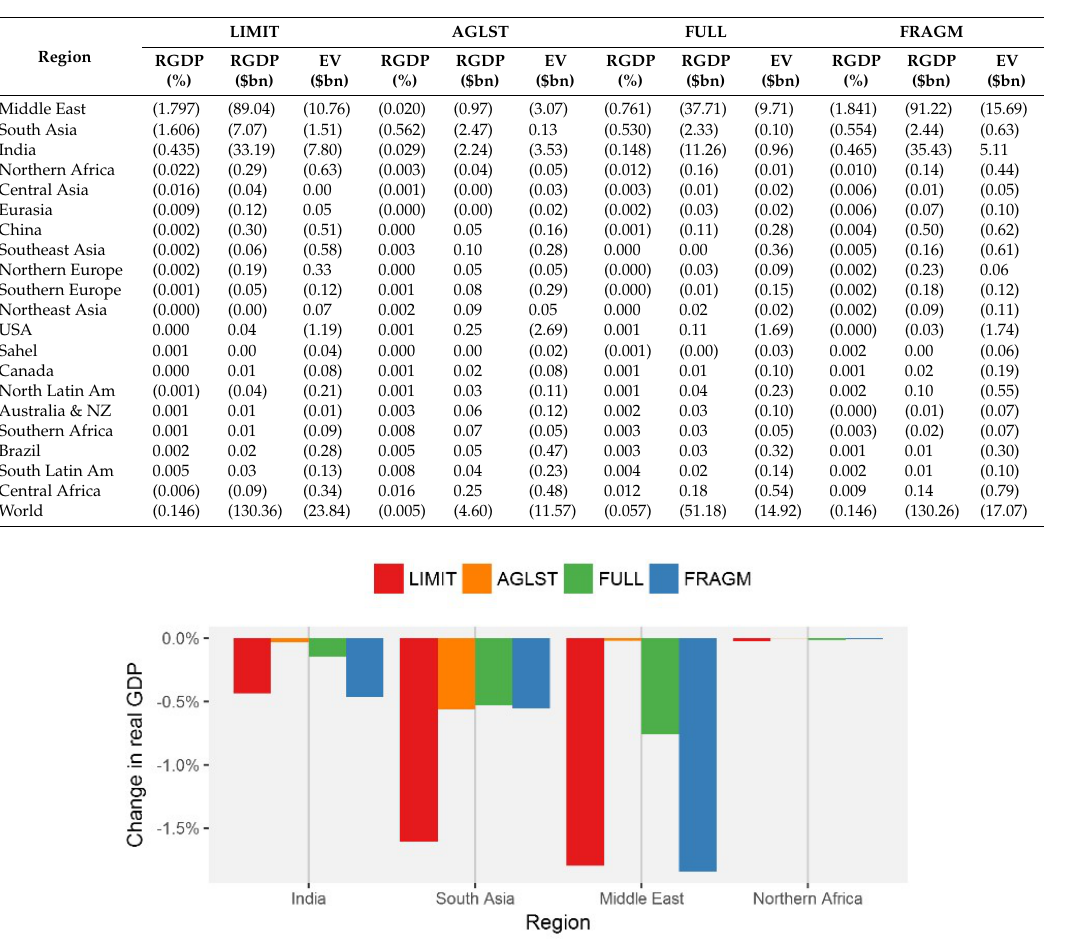
Figure 5. Sectoral output impacts in water‐scarce regions.